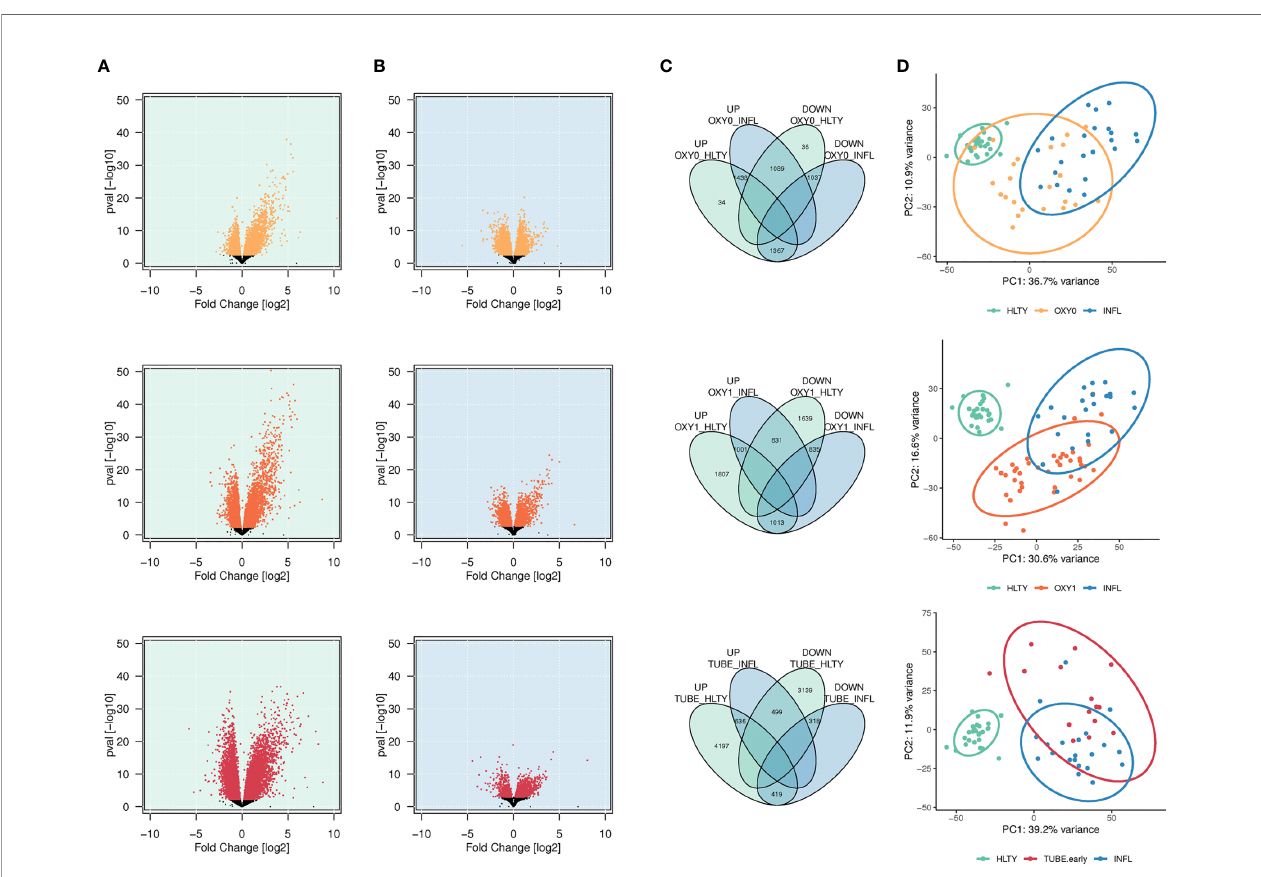
FIGURE 1 | Differential genes expression analysis. (A, B) Volcano plots showing the distribution of log2 fold changes and P-values of differentially expressed genes (DEGs) among SARS-Cov-2 infected patients represented in yellow (no oxygen support, OXY0), orange (oxygen support, OXY1) and red (intubated with sampling within 7 days in hospital, TUBE EARLY), respectively, using non-infected controls (HEALTHY, green shadow, A ) and In fl uenza-infected patients (INFLUENZA, blue shadow, B ), as a reference group. Genes with a -log10 (P-value) not signi fi cant once adjusted for multiple testing (adjusted P > 0.01) are represented in black (C) . Venn diagram showing the number of up or down regulated DEGs in each comparison, and number of common DEGs between comparisons. (D) Principal component analysis of gene expression in In fl uenza, severe and non-severe SARS-CoV-2 infected patients. The fi gure presents the two major principal components using the 10% of most signi fi cant DEGs. Ellipses were drawn using the stat-ellipse function of the R ggplot2 package, using default